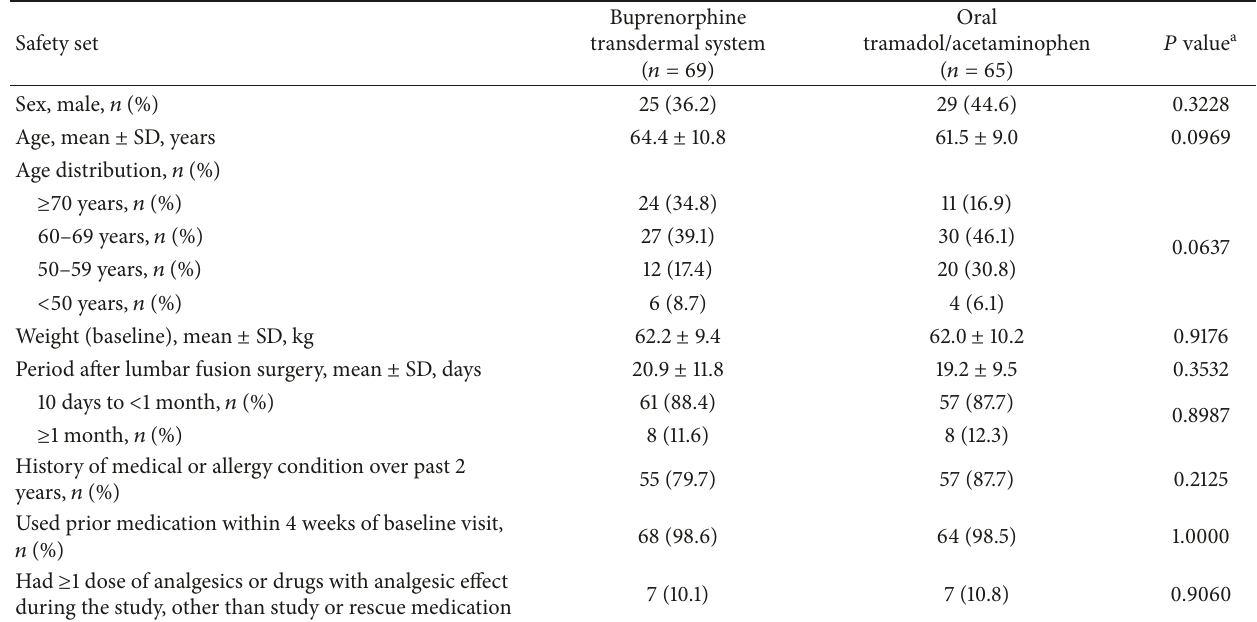
Table 2: Patient characteristics and medical conditions.